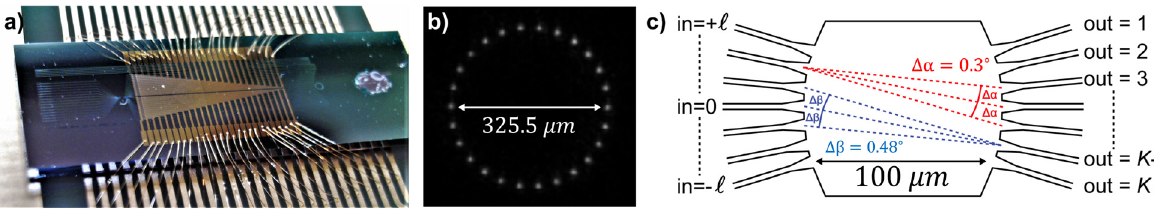
Figure 2: Compact and scalable design of photonic integrated chips. (a) Picture shows the photonic integrated device used in the experiment. (b) Infrared image of the grating couplers output. The 26 output are arranged on a ring of 325 . 5 μ m. (c) Schematic of the star-coupler